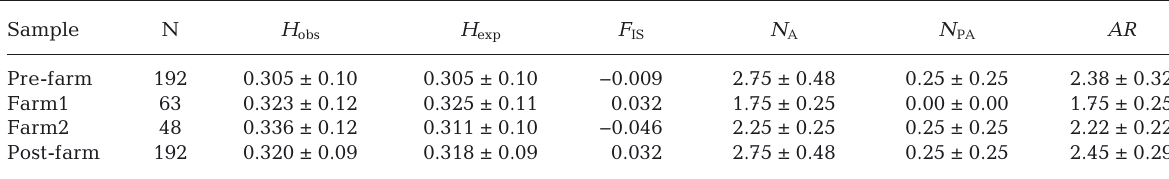
Table 3. Genetic characterization of Atlantic cod samples by allozyme loci. N: number of allozyme-genotyped individuals, H obs : observed hetero zygosity, H exp : expected heterozygosity, F IS : Wright’s F IS value, N A : number of alleles, N PA : number of private alleles, AR : allelic richness. Mean values are given ± SE